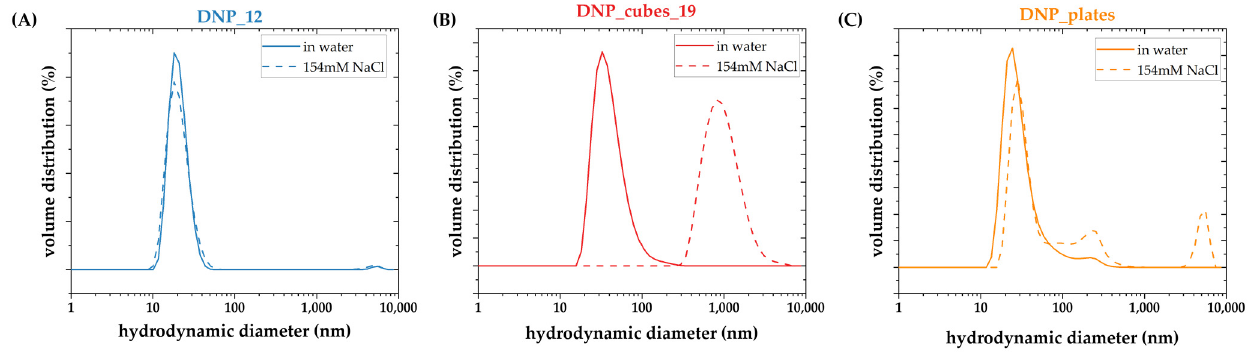
Figure 11. DLS size distribution in the volume of ( A ) DNP_12, ( B ) DNP_cubes_19, and ( C ) DNP_plates measured at 0.1 mg Fe/mL in water (straight line) or in physiological media (154 mM NaCl solution) (dashed line). NaCl solution) (dashed line).